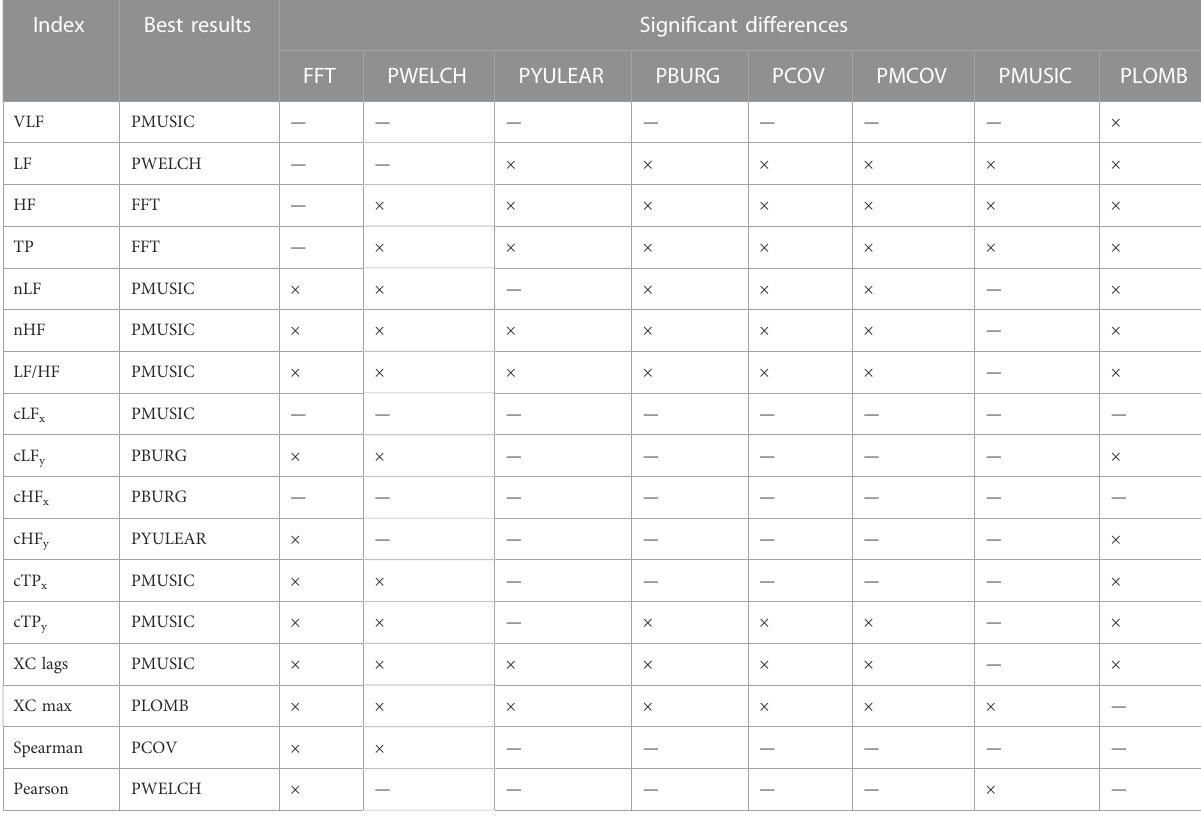
TABLE 5 Summary of results obtained from the Kruskal-Wallis one-way analysis of variance and post hoc comparisons for pulse rate variability obtained from acceptable quality PPG signals. ×: Signi fi cant differences. — : Non-signi fi cant differences.